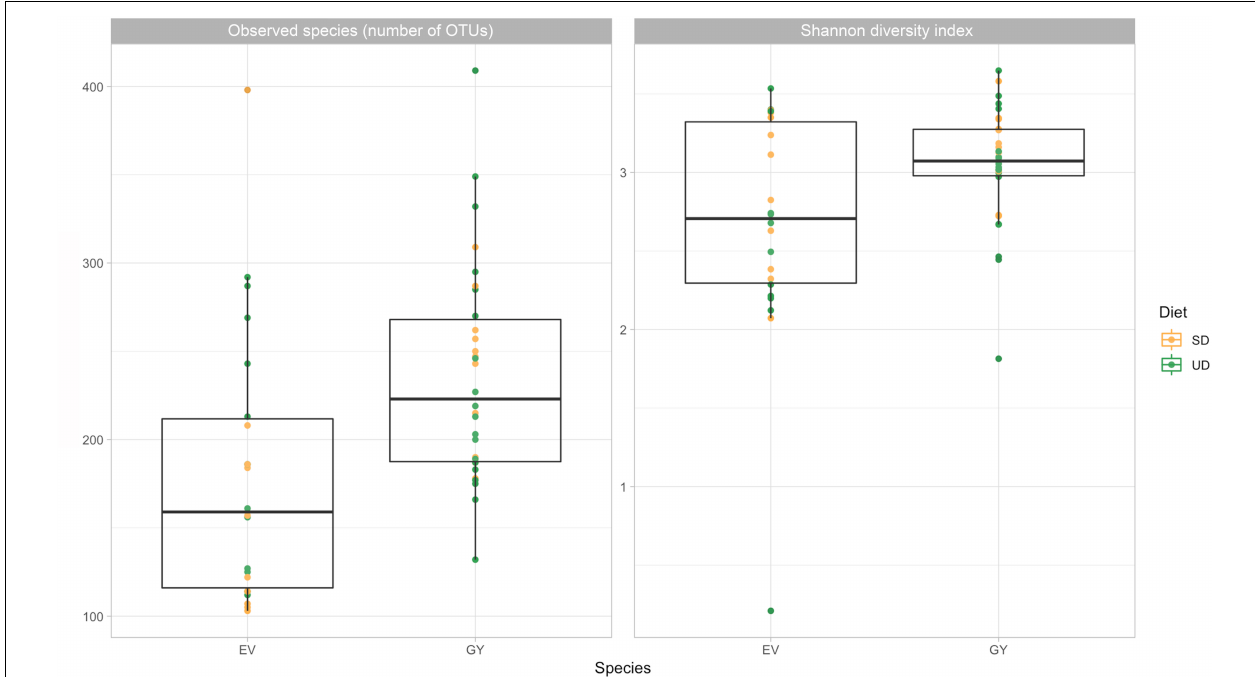
FIGURE 1 | Variation in gut bacterial diversity between Egyptian and Griffon vultures. Alpha diversity based on rarefied data, measured by observed species and Shannon diversity Index, plotted for 52 fecal samples of two Old World vulture species (EV = Egyptian vulture, six individuals, n = 22 samples; GY = Griffon vulture, seven individuals, n = 30 samples). Statistical testing showed significant difference in observed species (Wilcoxon, P < 0.05) and Shannon diversity (Wilcoxon, P < 0.05) between both vulture species. Vultures were fed either a sanitized diet (SD) consisting of skinned, de-gutted and washed rats, chicken and quail, or un-sanitized diet (UD) consisting of intact whole rats, chicken and quail. No significant difference were observed between